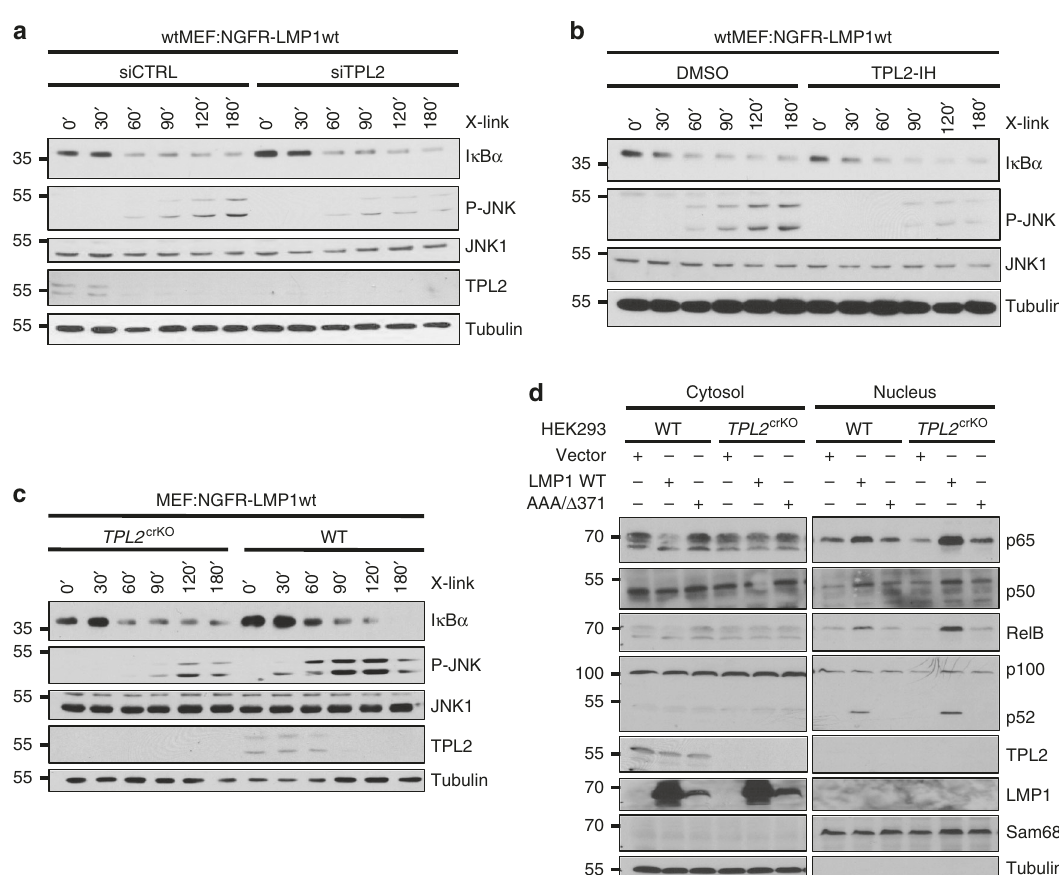
Fig. 5 TPL2 mediates JNK activation by LMP1, but it is dispensable for NF- κ B induction. a The knockdown of TPL2 interferes with JNK activation by LMP1. Wildtype MEF:NGFR-LMP1wt cells were transfected twice with siRNA targeting TPL2 (siTPL2) or non-targeting control siRNA (siCTRL) prior to NGFR-LMP1 activation. b Pharmacological inhibition of TPL2 attenuates JNK activation by LMP1. Detection of JNK and NF- κ B activation by NGFR-LMP1 in wtMEF:NGFR-LMP1wt cells in the presence of DMSO or 10 μ M of the TPL2 inhibitor TC-S7006 (TPL2-IH). c The knockout of TPL2 inhibits JNK signaling by LMP1. TPL2 was targeted by CRISPR/Cas9 in wtMEF:NGFR-LMP1wt cells. NGFR-LMP1 was induced in wildtype and TPL2 crKO (clone 8) MEFs. JNK and NF- κ B activation were analysed. d The knockout of TPL2 in HEK293 cells does not impair canonical or non-canonical NF- κ B activation by LMP1. TPL2 was inactivated in HEK293 cells by CRISPR/Cas9 technology. HEK293 wildtype and TPL2 crKO HEK293 (clone 1) cells were transfected with HA-LMP1 wildtype, inactive AAA/ Δ 371 – 386 mutant or empty vector as indicated. Cytoplasmic and nuclear fractions were prepared and analysed by immunoblotting with the indicated antibodies. TPL2 knockouts were veri fi ed at the protein level (this Figure) and by sequencing (Supplementary Table 2). a – d The data are representative of at least two independent experiments. For immunoblot quanti fi cation and statistics see Supplementary Table